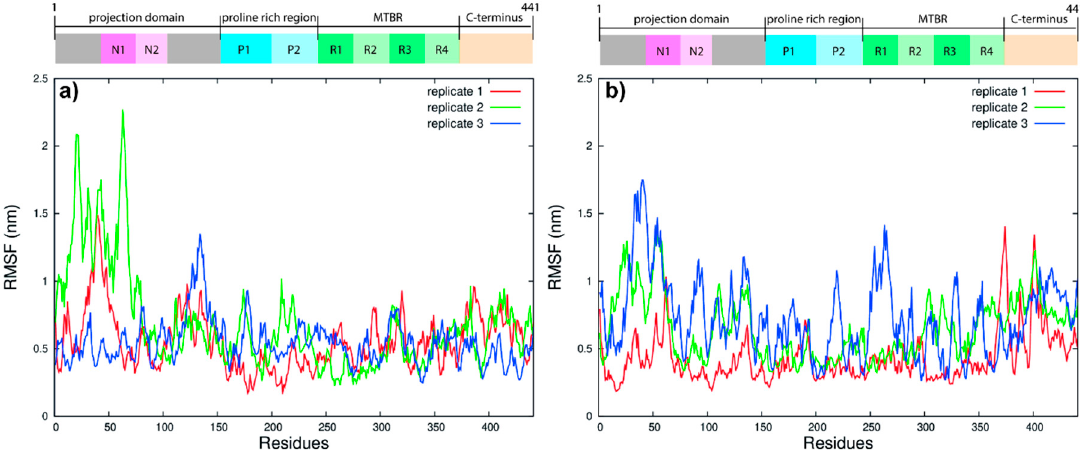
Figure 6. Residue root-mean-square fluctuation (RMSF) ( a ) of each tau replicate in fluid and ( b ) of tau::microtubule pair in fluid.